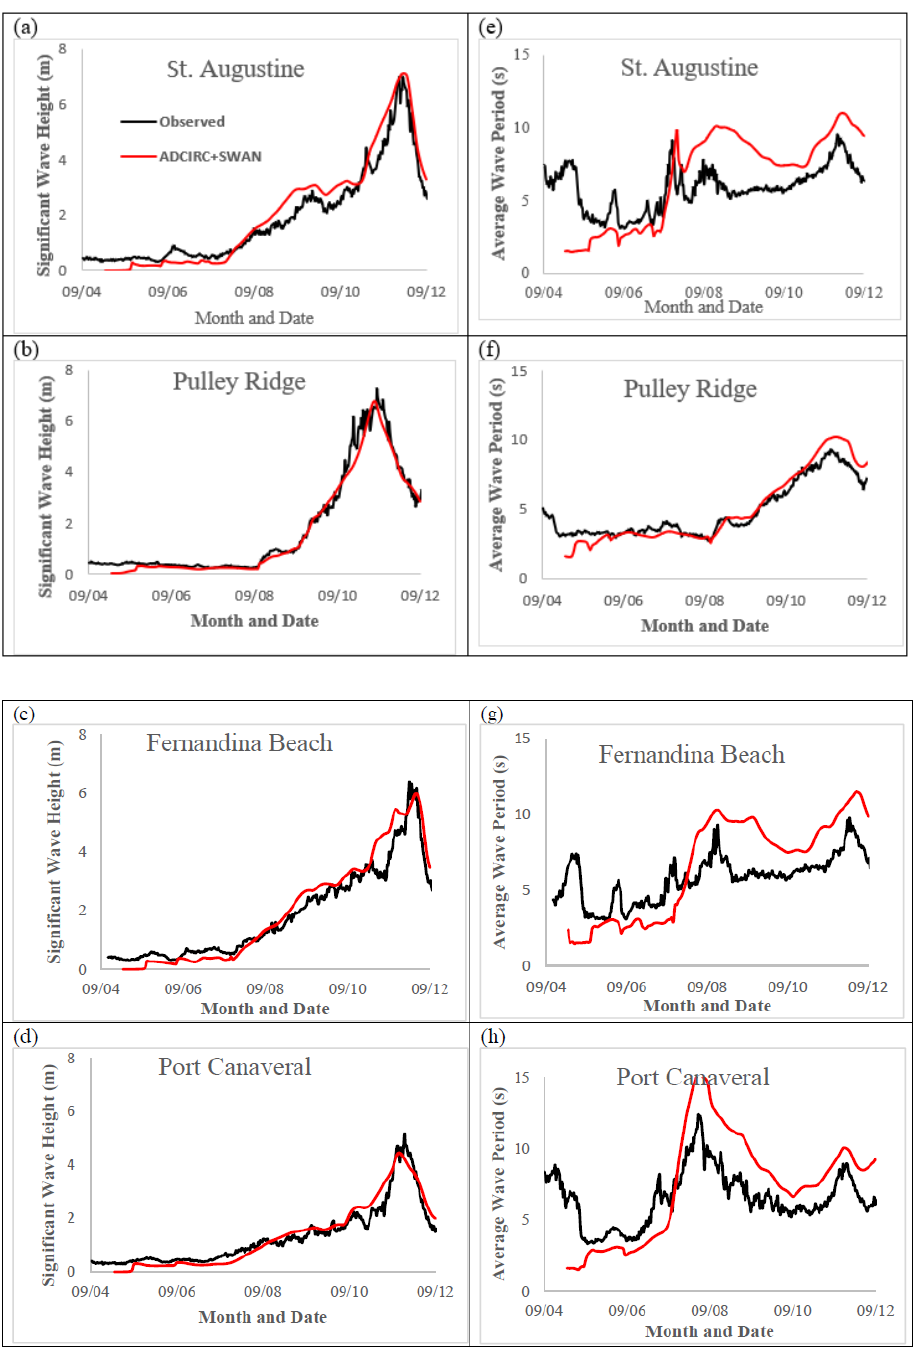
Figure 5. Observed and modeled significant wave height (m) (left column), and average wave period (s) (right column) time series (2017) for Hurricane Irma at selected stations using ADCIRC+SWAN: ( a , e ) St. Augustine, ( b , f ) Pulley Ridge, ( c , g )Fernandina Beach, and ( d , h ) Port